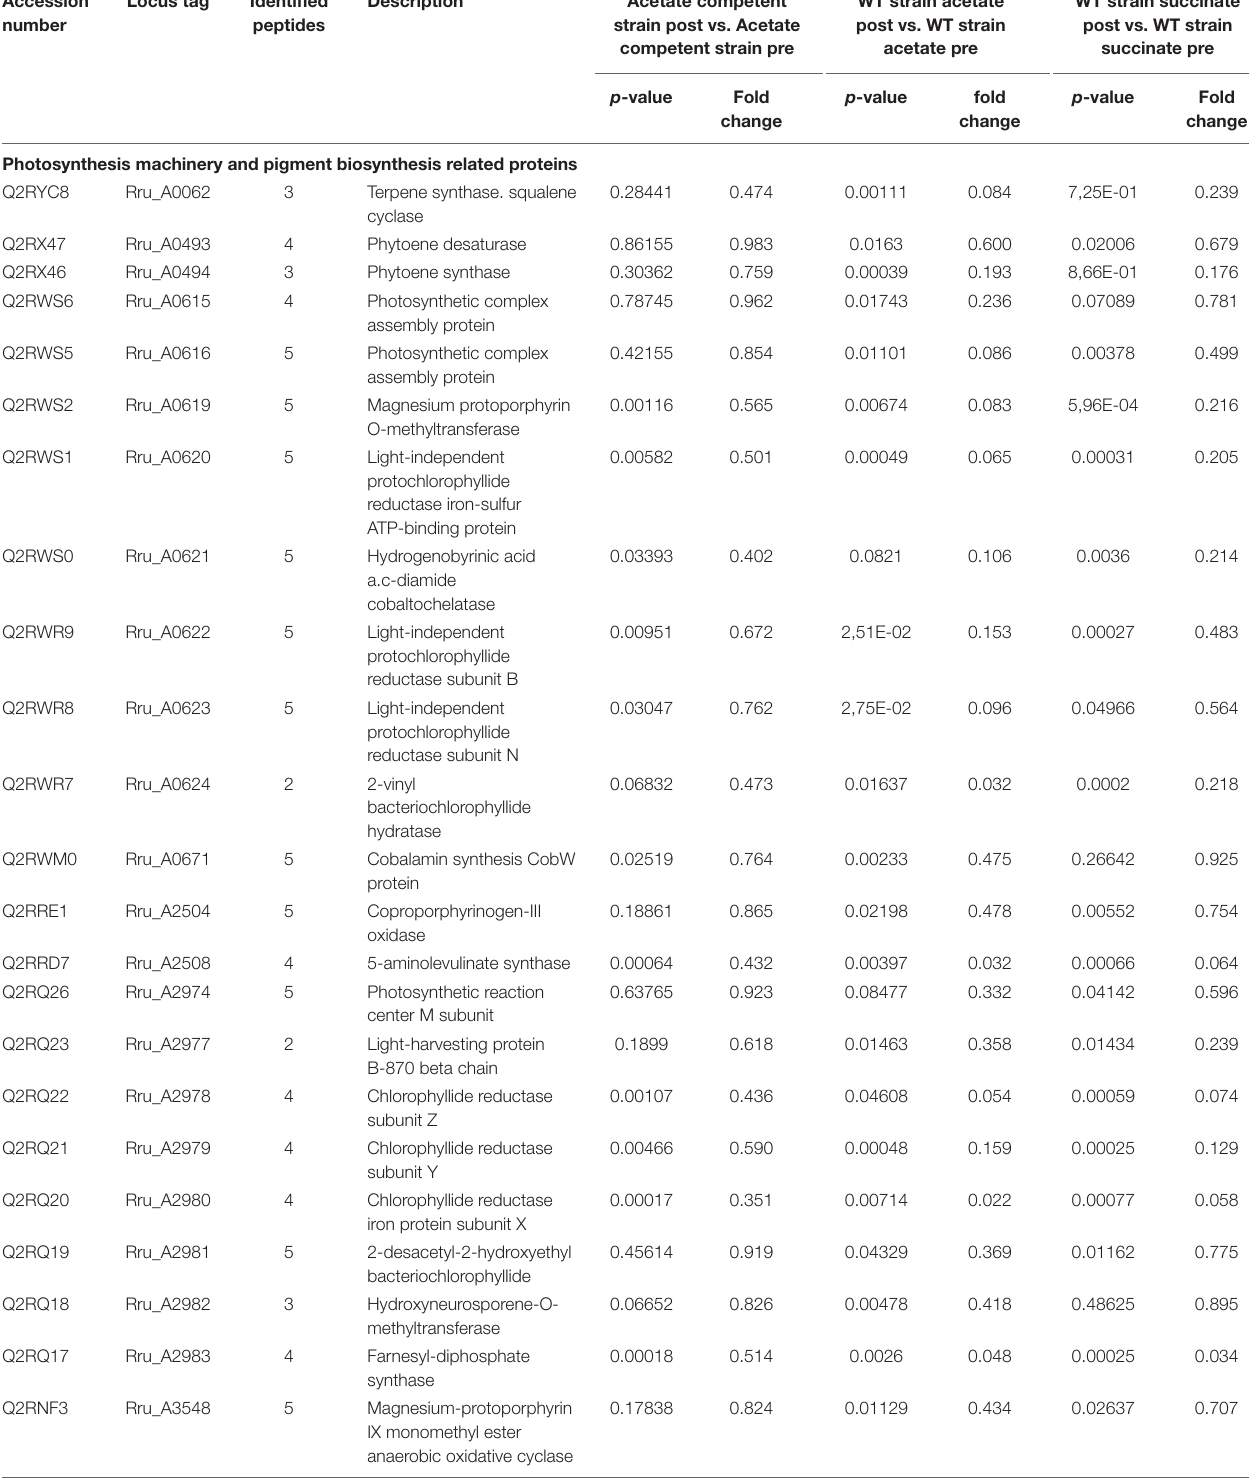
TABLE 1 | Differential abundance of selected ( p ≤ 0.05; fold change ≤ 0.66 or ≥ 1.5)